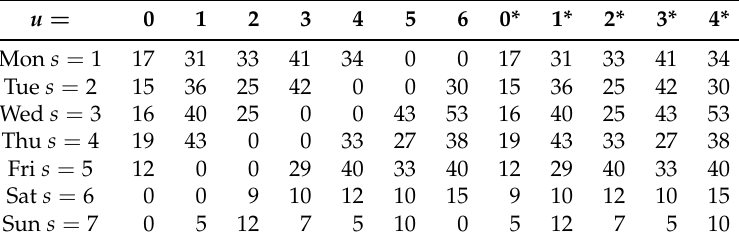
Table 3. Observed number of reported claims M (cid:48)(cid:48) s , u ( τ m ) for weekdays 1 ≤ s ≤ 7 and reporting delays 0 ≤ u ≤ 6 = u ( 1 ) − 1 at time τ m = 31/10/2010 for claims with accident dates before 26/10/2010 of LoB Casualty, the rhs is compressed by weekends. u